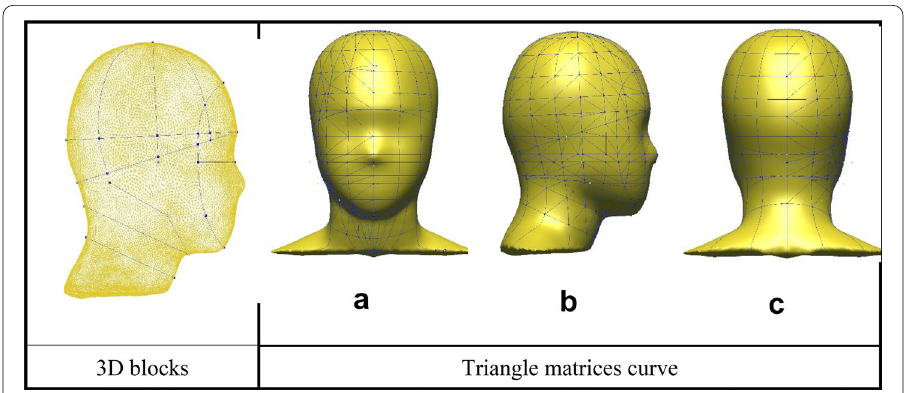
Fig. 4 3D block and triangular curved mesh creation for pattern development. a Front view; b right view; c back